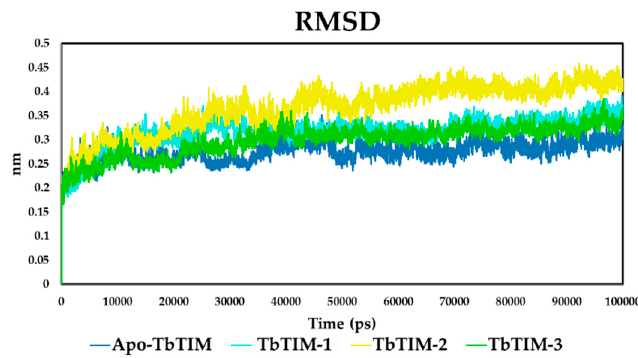
Figure 4. Root mean square deviation (RMSD) of free enzyme (Apo-TbTIM) and the TbTIM-compound complexes.